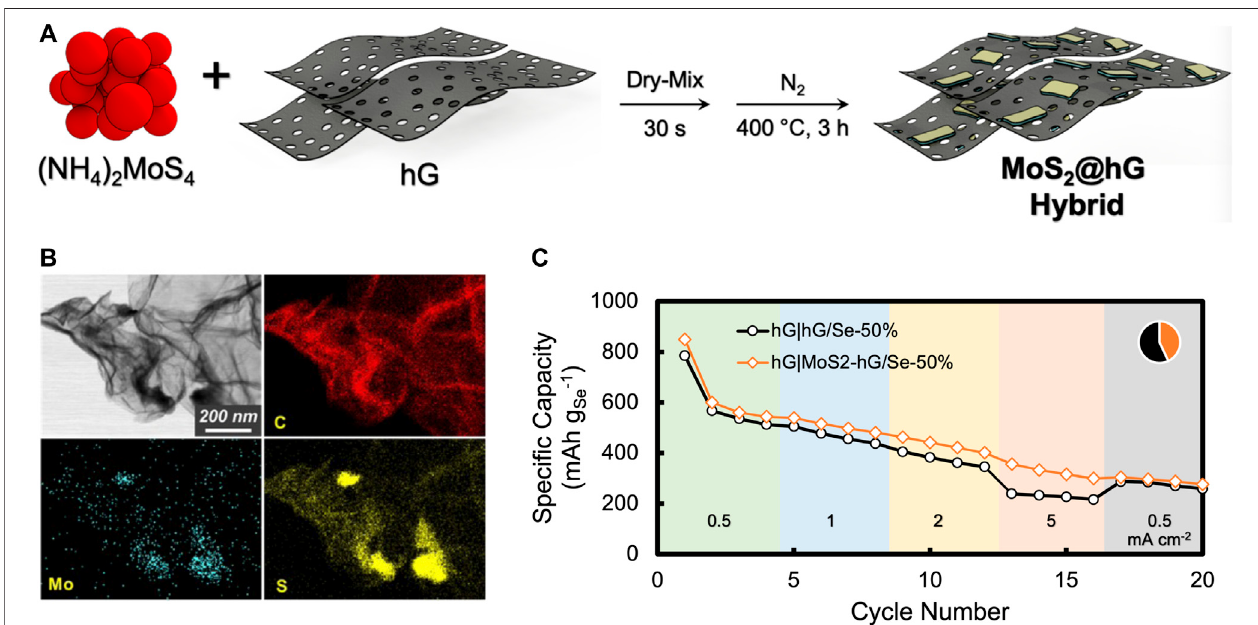
FIGURE 5 | Toward entrapping soluble polyselenides: (A) solvent-free synthesis of the MoS 2 @hG hybrid; (B) a typical TEM image and the corresponding C, Mo, andSEDSmapsoftheMoS 2 @hGhybrid; (C) Li-SebatteryperformancewithahG|hG/Se-50%cathodevs.ahG|MoS 2 -hG/Se-50%cathodeinaprotocol,where J A was sequentially held at 0.5, 1, 2, 5, 0.5 mA cm − 2 (each for 4